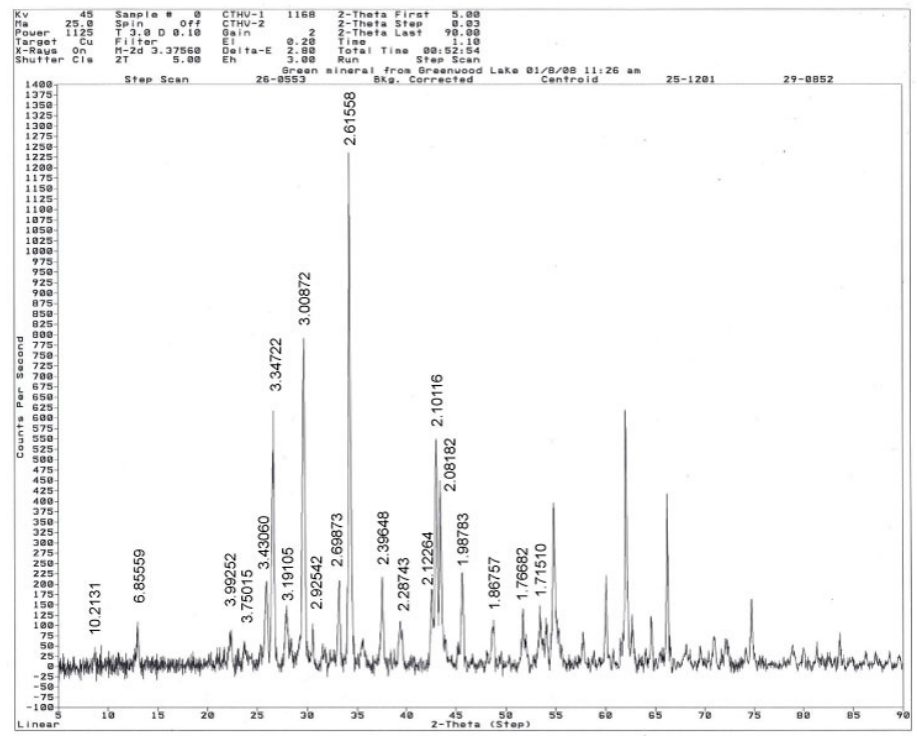
Figure 4. X-ray di ff raction pattern of kornerupine from Ringwood showing the principal index peaks Figure 4. X-ray diffraction pattern of kornerupine from Ringwood showing the principal index and their d-spacing (vertical peaks and their d-spacing (vertical values).